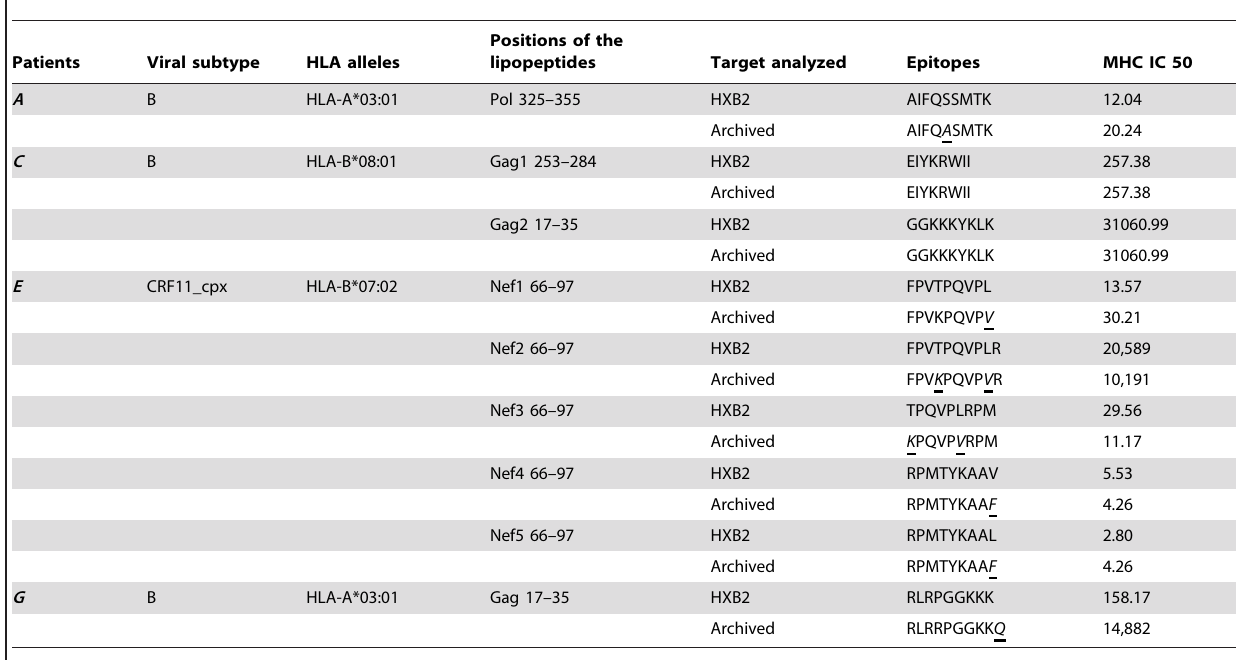
Table 2. Potential CTL reactivity against archived viral epitopes according to HLA I alleles: cross-reactivity to Lipo 5 peptides.